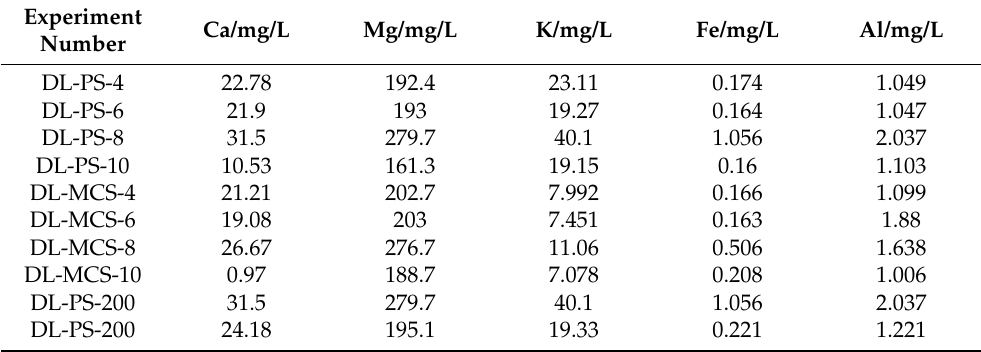
Table 3. Metallic-element content in dynamic